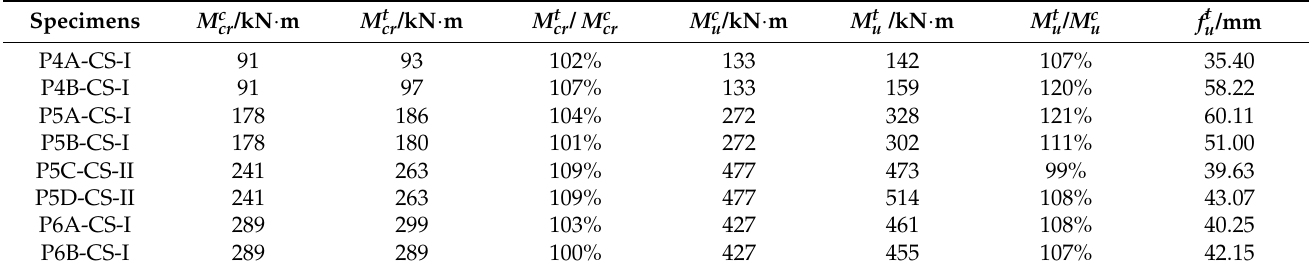
Table 5. Flexural performance parameters of